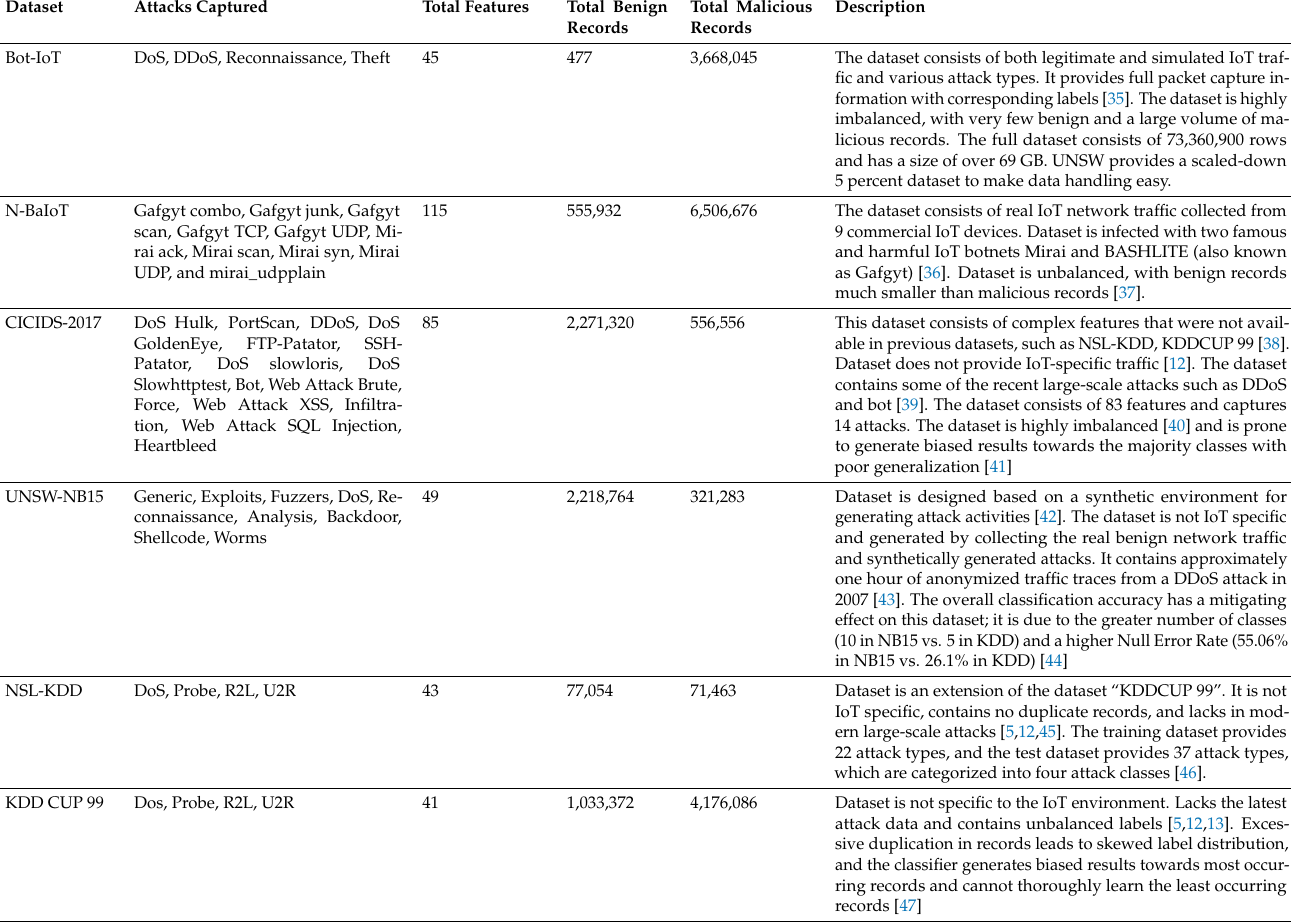
Table 1. Benchmark datasets